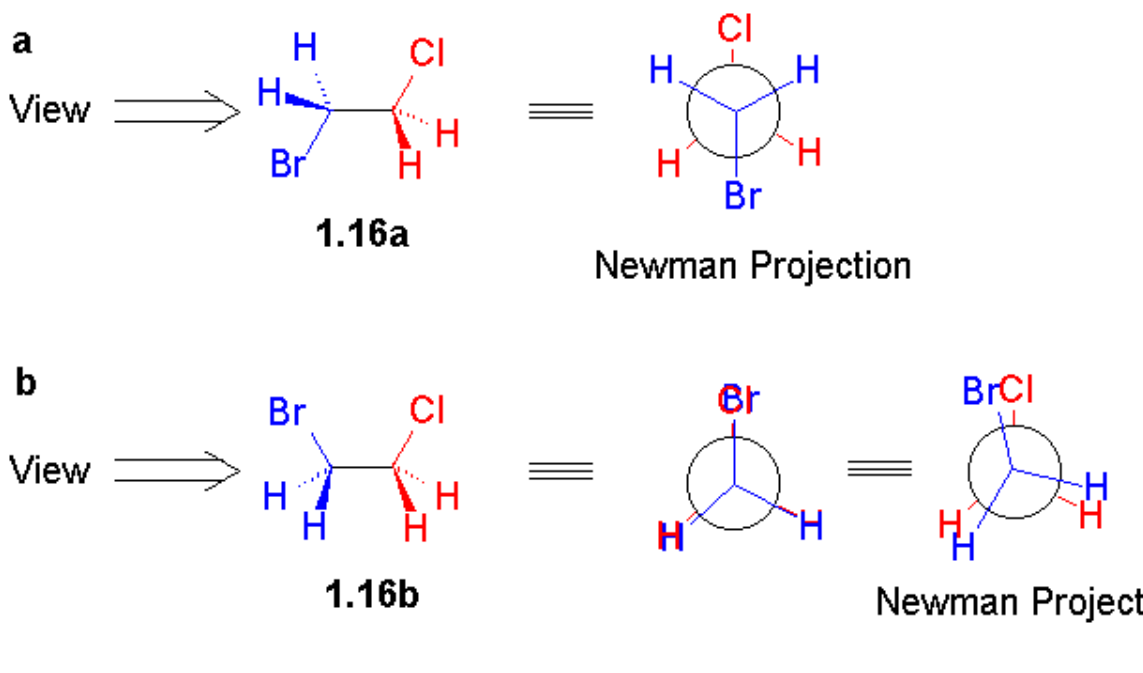
Figure 2. Wedge / hash and Newman projections of two stereoisomers of